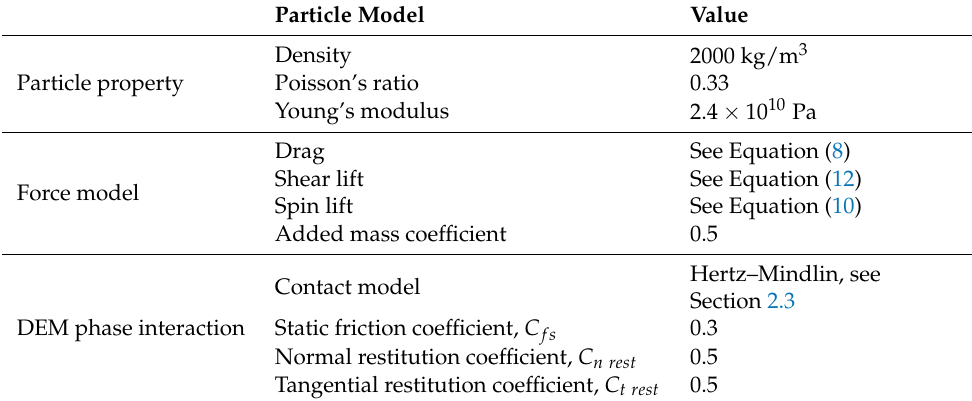
Table 2. Particle property and parameters for the DEM